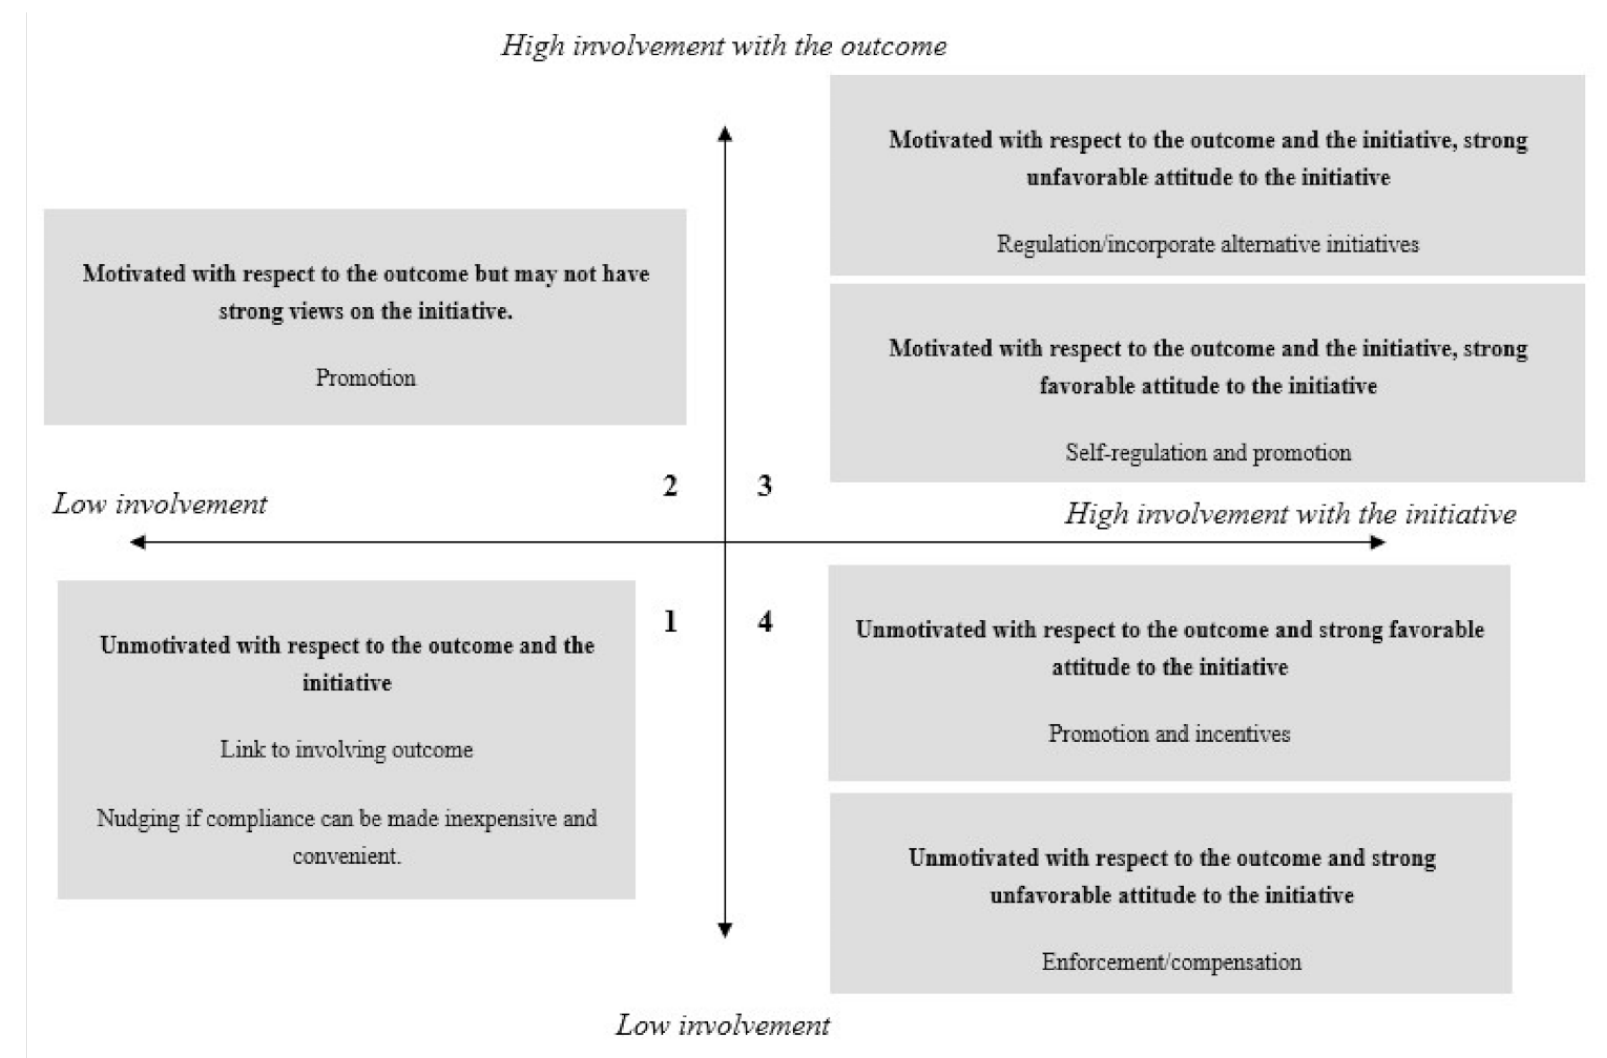
Figure 1. I 3 Response framework. Note. Bold text describes the strength of motivation with respect to the policy outcome (e.g., reducing possums) and the policy initiative (e.g., subsidised traps). Plain text describes potential measures to promote compliance with the initiative (source: adapted from